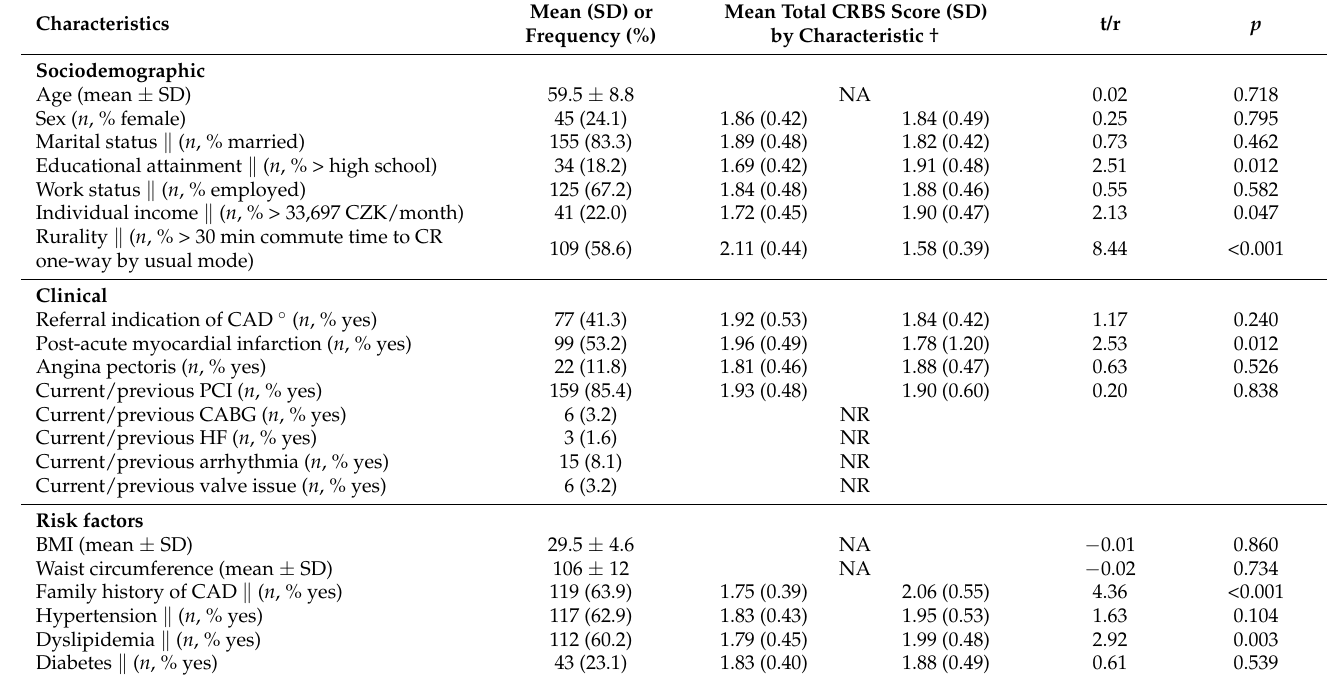
Table 1. Participant characteristics ( n =